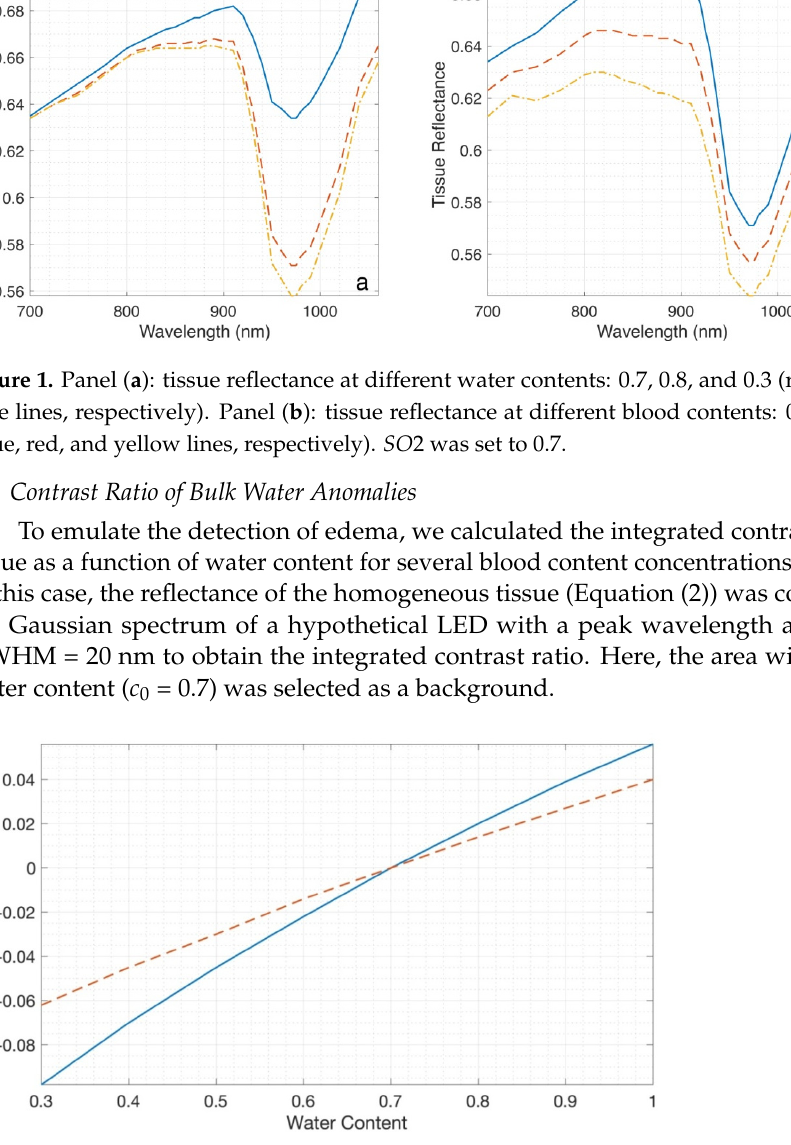
Figure 2. The integrated contrast ratio as a function of water content for several blood content concentrations: c Hb = 0.01 and 0.1 (solid blue and dashed red lines, respectively). SO 2 was set to 70%. The normal water content ( c 0 =0.7) was selected as a background.